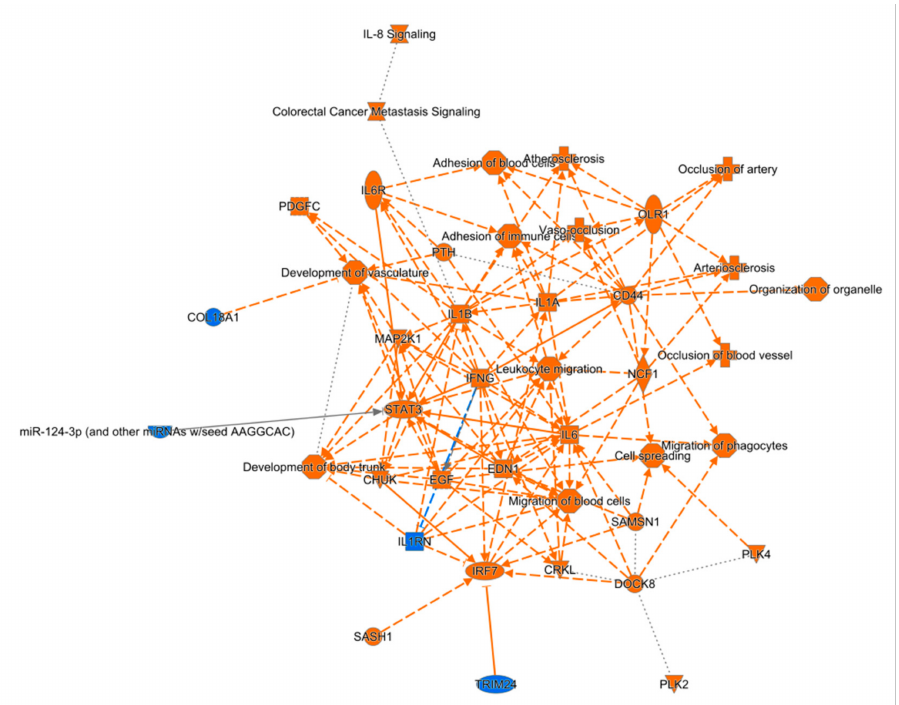
Figure 3. Graphical summary of pathway analysis of differentially expressed genes in the perilesional cortex after traumatic brain injury. Analysis highlighted physiologic functions like organismal survival, tissue morphology, nervous system development and function, and hematologic system development and function.